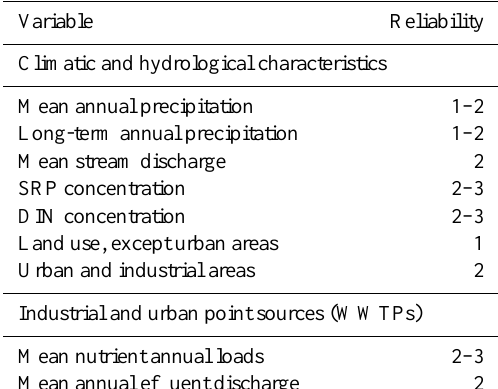
Table 1. Reliability rating of the sources of data. Scores range from 1 to 5, where 1 is most reliable and 5 is least